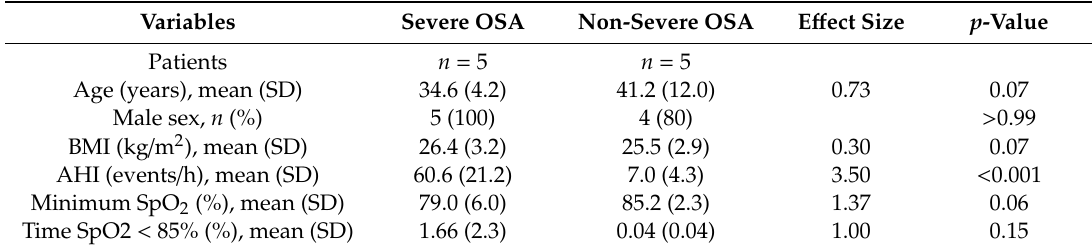
Table 1. Di ff erences in patient characteristics between the severe obstructive sleep apnea (OSA) and non-severe OSA groups.